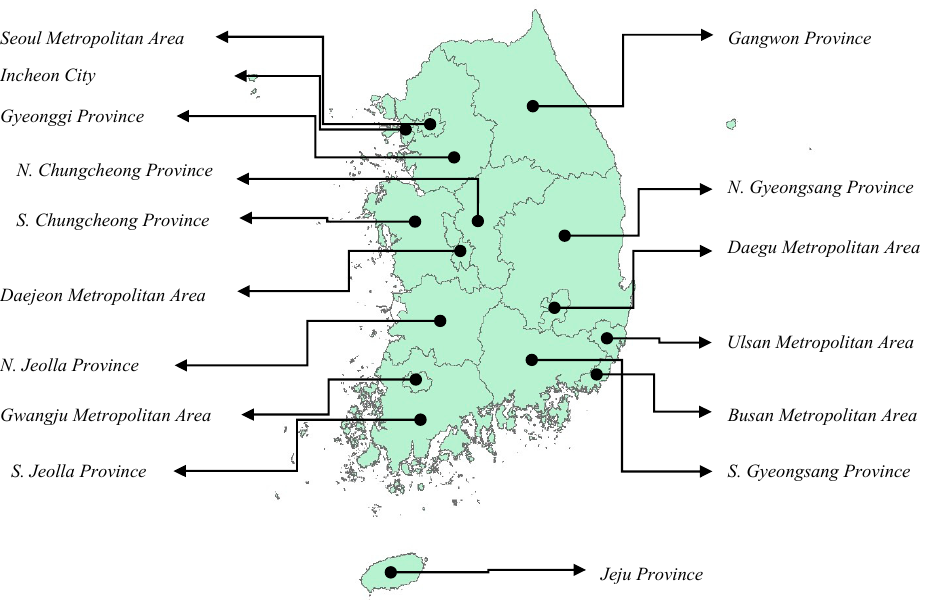
Figure 1. Map of South Korea with regional identification.